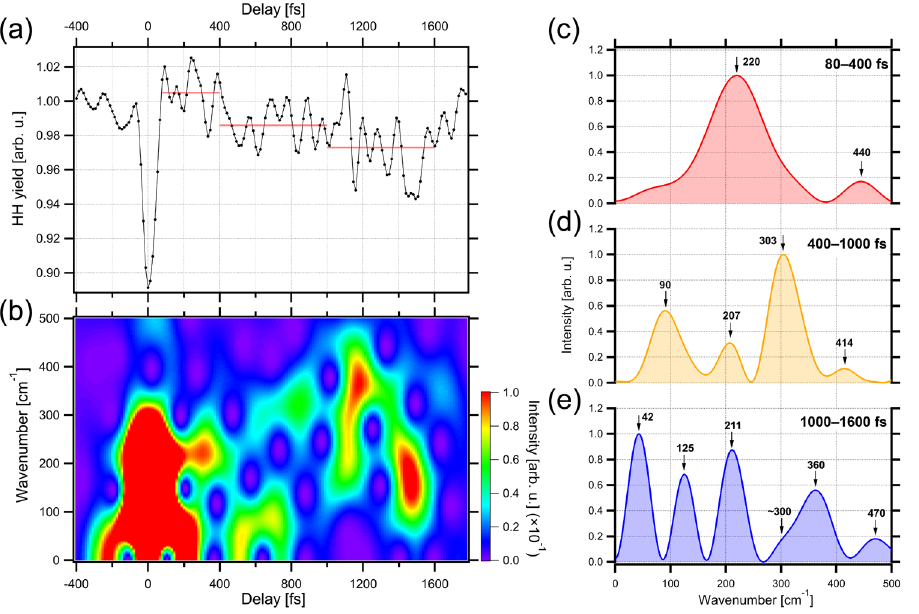
Fig. 2. (a) Experimentally observed yield of the 19th harmonic. The horizontal red lines show the average values of the data points (black dots) within the range of the length of each red line. (b) Short-time Fourier spectra of the transient harmonic yield [black dots in (a)]. (c)-(e) Experimentally extracted modulation frequencies of the 19th harmonic yield. The colored curves were obtained by Fourier transforming the data points in the following delay ranges: (c) 80 − 400 fs, (d) 400 − 1000 fs, and (e) 1000 − 1600 fs. The black arrows depict the peak positions (in cm − 1 ) of the